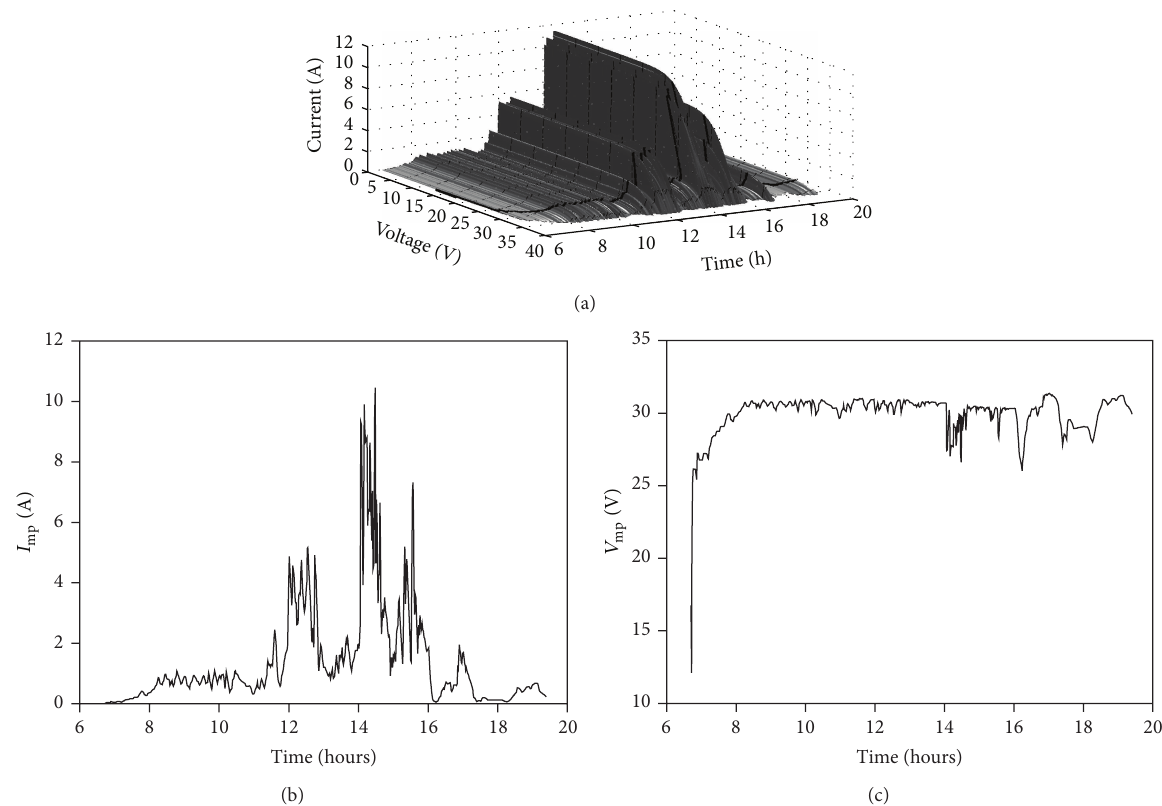
Figure 7: Evolution of the I - V curve of YL280C-30b monocrystalline solar panel according to ambient conditions, that is, sun irradiance and panel temperature levels, on May 13, 1971 (a), at the Goddard Space Flight Center (GSFC). Evolution of current (b) and voltage (c) at maximum power point